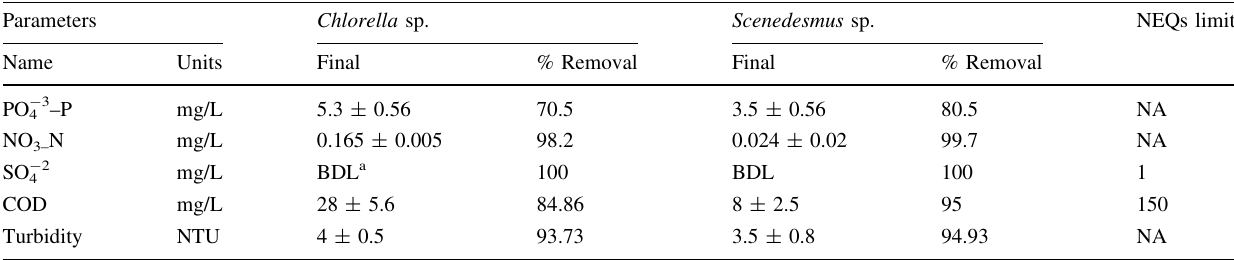
Table 4 Percentage removal (maximum) of pollutants by the 7th day of incubation